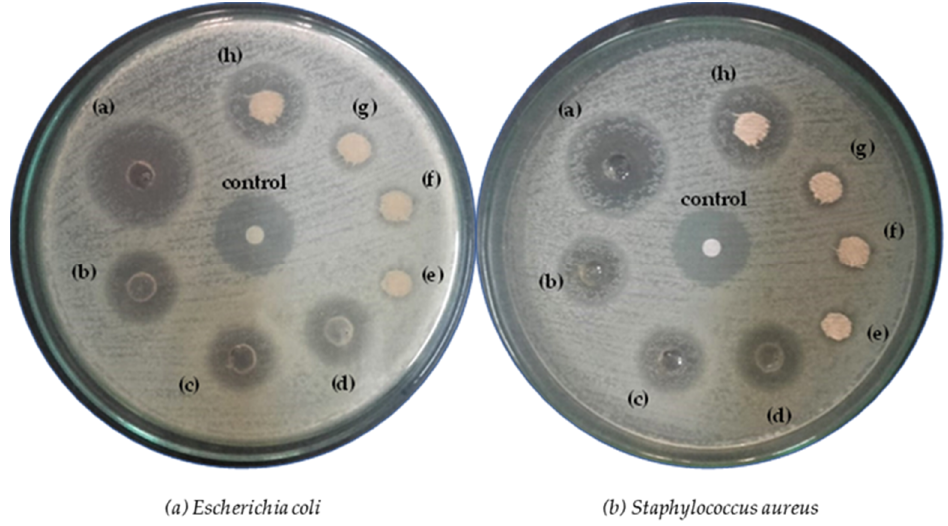
Figure 3. Antibacterial activity in media of different rose extracts (a–d) and dyed fabrics (e–h) against Gram-negative bacterium Escherichia coli ( a ) and Gram-positive bacterium Staphylococcus aureus ( b ).